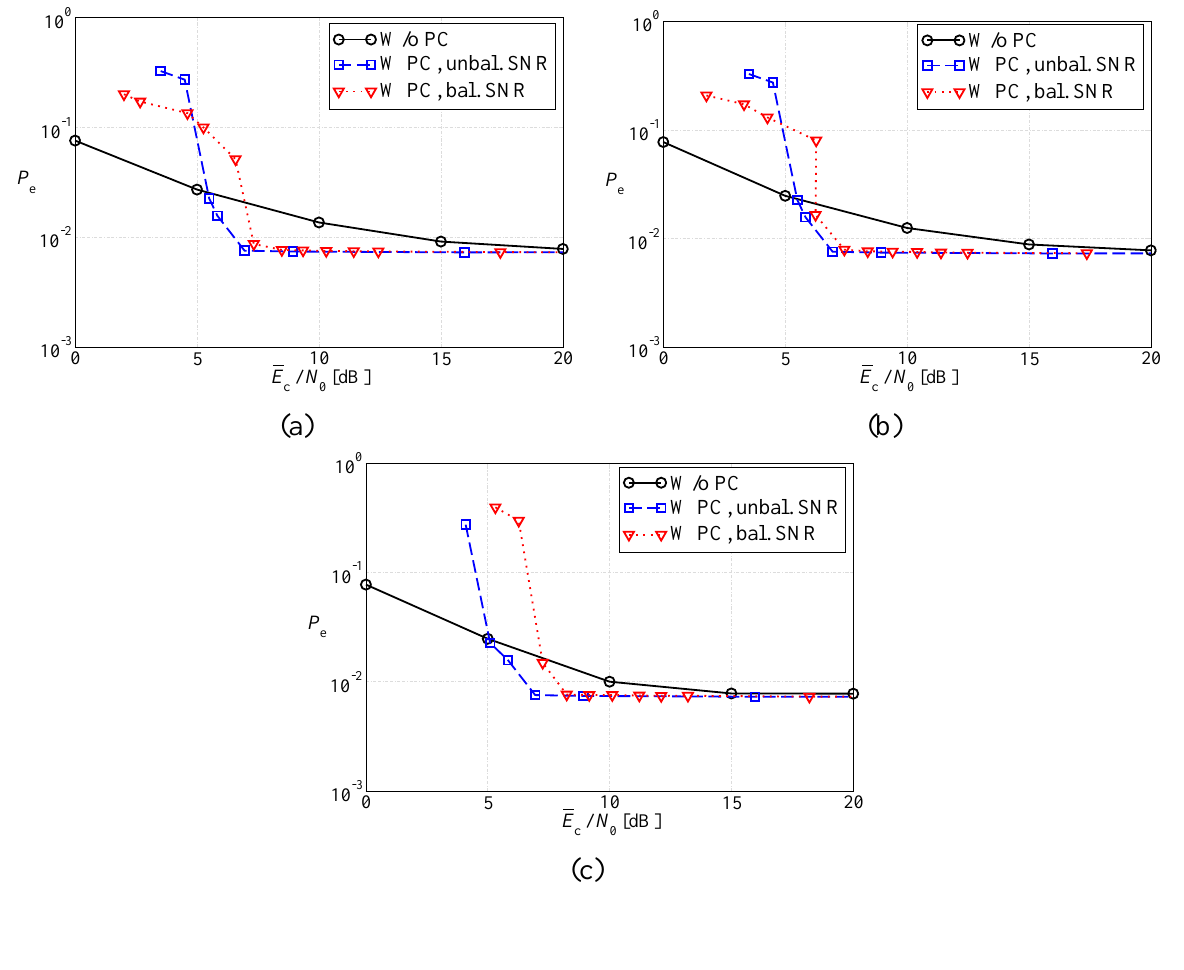
Figure 15. Error probability, as a function of the average SNR at the sources, for the CEO problem in a scenario with n = 3 sensors and considering: (a) regular LDPC-coded schemes, (b) DD LDPC-coded schemes, and (c) SCCCed schemes. The performance in the presence of balanced SNR and unbalanced SNR power control strategies is compared with that associated to the absence of power